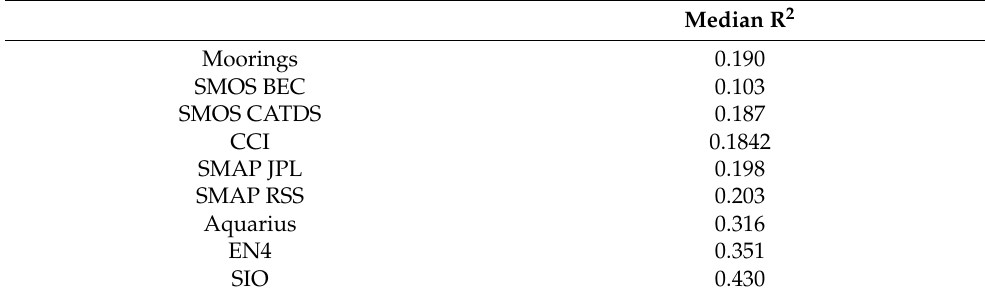
Table 3. Median R 2 over all the mooring locations for all the products for the annual harmonic. The number of mooring locations used in each of these values is listed in Table